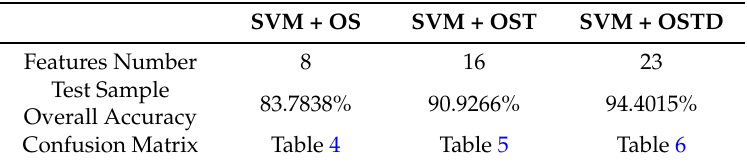
Table 3. Overall mapping accuracy using the three different sets of features.